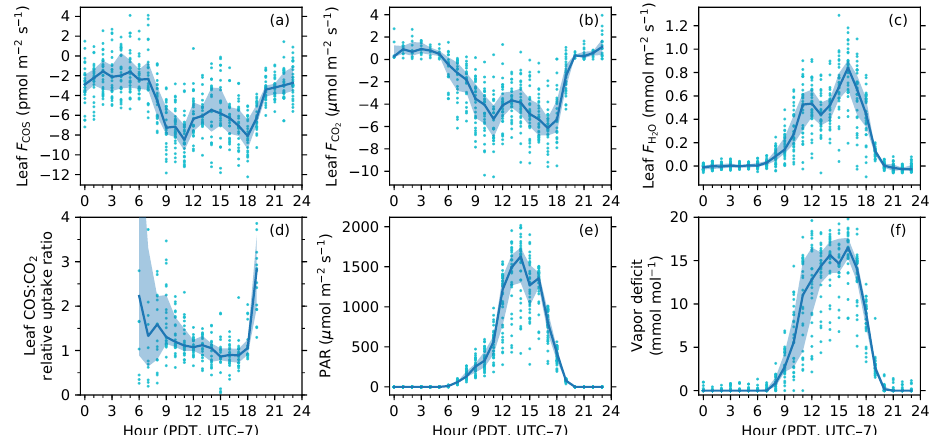
Figure 3. Diurnal patterns of leaf COS (a) , CO 2 (b) and water (c) fluxes, leaf relative uptake ratio (d) , PAR at the leaf chamber (e) , and leaf-to-air vapor deficit in mole fraction (f) . The solid curves show medians binned by the hour of the day (Pacific Daylight Time, UTC − 7), and the upper and lower bounds of shaded areas are the 25th and 75th percentiles, respectively.